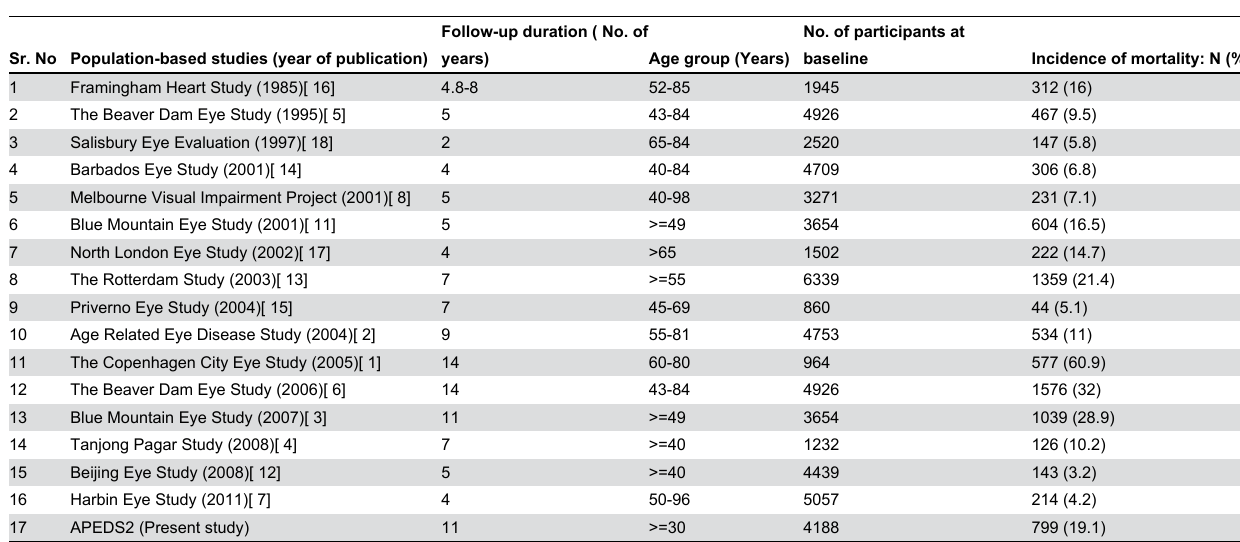
Table 6. The incidence of mortality and duration of follow up duration across different studies.